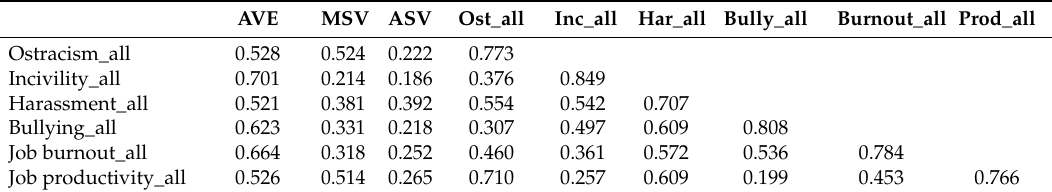
Table 3. Discriminant Reliability.